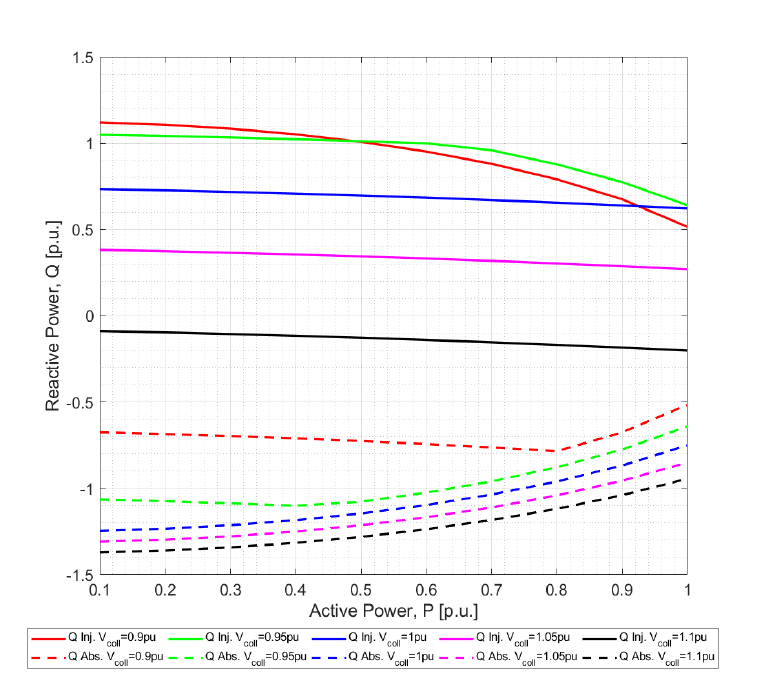
Figure 4. Wind turbine capability curve at the WPP collection system